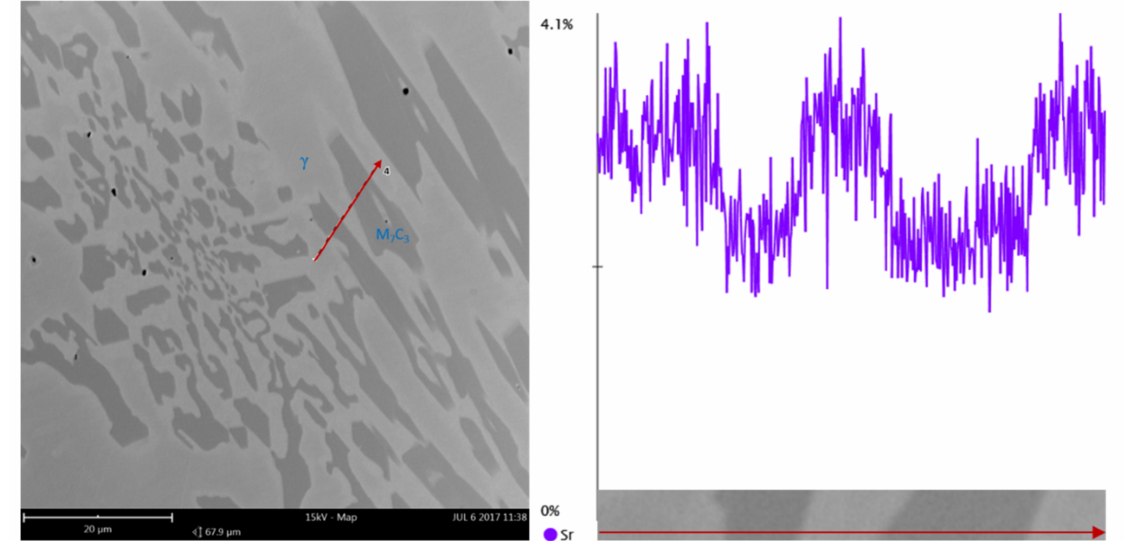
Figure 11. EDS linear analysis of Sr level in the eutectics of chromium cast iron sample with 0.005% Sr addition, SEM